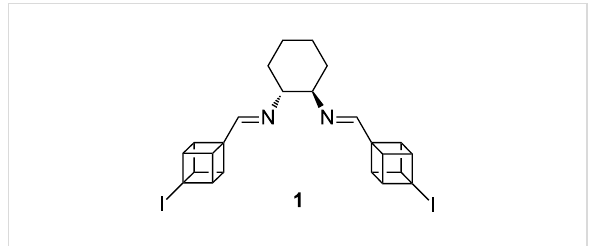
Figure 1: Structure of (1 R ,2 R )- N , N ’-bis[(4-iodocuban-1-yl)methylene]- trans -1,2-diamino cyclohexane ( 1